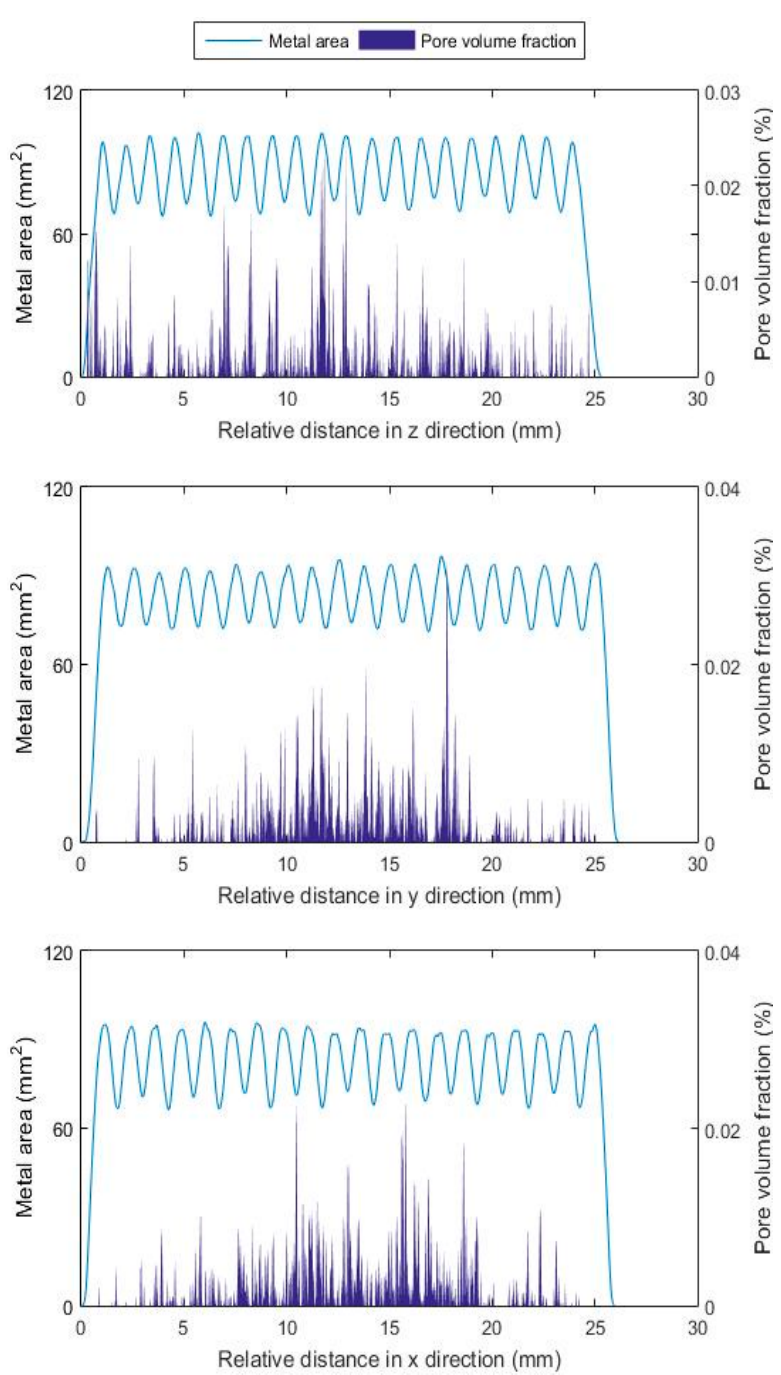
Figure 4. Metal area and pore fraction per slice with distance from the edge of the diamond sample. Top image shows the z direction parallel to the build direction, middle and bottom images the other two orthogonal directions.